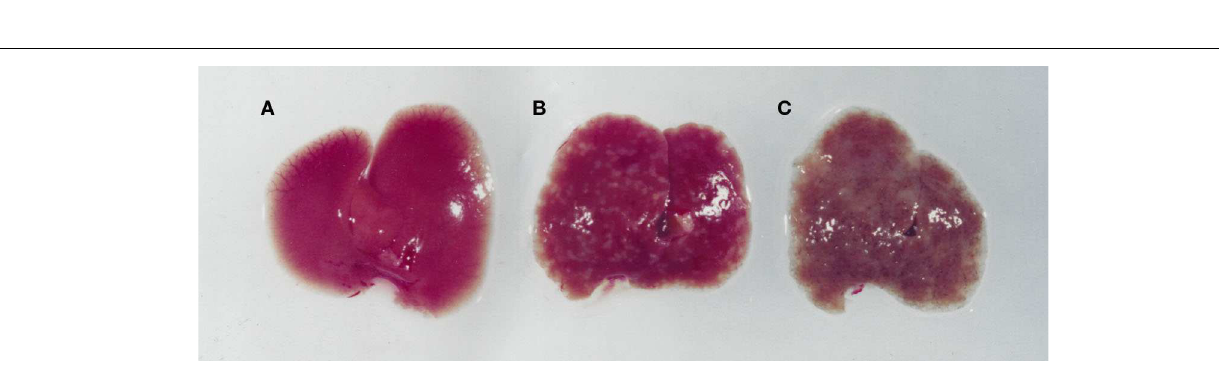
FIGURE 3 | Images of livers from an uninfected (A), an S. mansoni -infected immune competent (B), and immune suppressed (C) mouse. While an infected immunologically intact mice has granulomas in the liver (B) , in an immunodeficient mouse (C) there is marked whitening of the liver due to microvesicular